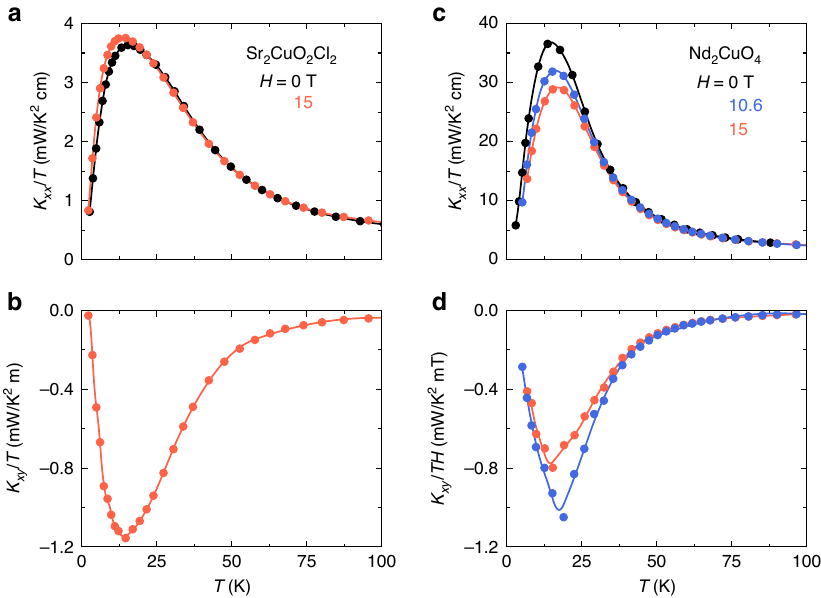
Fig. 2 Thermal transport in Sr 2 CuO 2 Cl 2 and Nd 2 CuO 4 . a Thermal conductivity of Sr 2 CuO 2 Cl 2 (sample A) in zero fi eld ( H = 0, black) and in a fi eld of 15 T applied parallel to the c -axis (light red), plotted as κ xx / T vs T . The fi eld is seen to increase κ xx slightly at low temperature. b Thermal Hall conductivity of Sr 2 CuO 2 Cl 2 (same sample) in a fi eld of 15 T applied parallel to the c -axis, plotted as κ xy / T vs T . c Thermal conductivity of Nd 2 CuO 4 , plotted as κ xx / T vs T , for three values of the magnetic fi eld applied parallel to the c- axis: H = 0 (black), H = 10.6 T (blue), and H = 15 T (light red). In this case, the fi eld is seen to decrease κ xx at low temperature. d Thermal Hall conductivity of Nd 2 CuO 4 , plotted as κ xy /( TH ) vs T , for two values of the magnetic fi eld applied parallel to the c -axis: H = 10.6 T (blue); H = 15 T (light red). The Hall conductivity κ xy is seen to be sublinear in H at low T and linear in H at high T ( T > 50 K). All lines are a guide to the